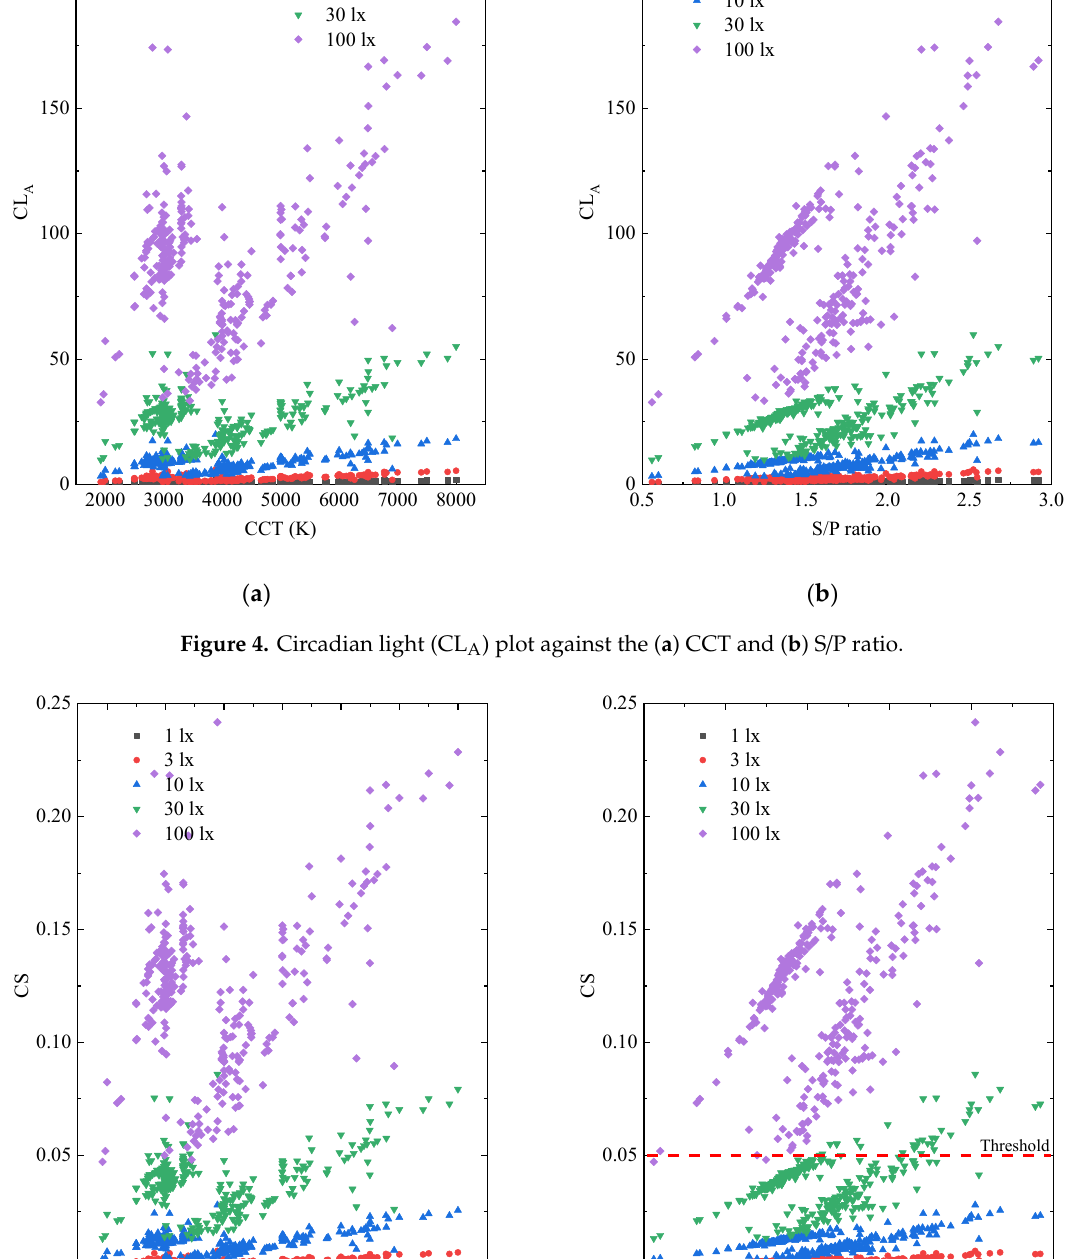
1 lx ( b ) Figure 3. ( a ) Equivalent melanopic lux (EML) plot against correlated color temperature (CCT) at an illuminance value of 1 lx. In the graph, x represents CCT, y represents EML, and k is the adjusting coefficient equal to the illuminance level, e.g., 1 at a 1 lx level. ( b ) EML plot against the S/P ratio at an illuminance of 1 lx. 3.2. CL A and CS as a Function of the CCT and S/P Ratio Figures 4 and 5 show CL A and CS as functions of the CCT and S/P ratio, respectively, at 1, 3, 10, 30, and 100 lx. At each illuminance level, both CL A and CS increase with the CCT and S/P ratio. However, the CL A and CS scatters are divided into two clusters. Both CL A and CS increase with illuminance levels. However, despite presetting a similar trend, they are not simple linear relations.